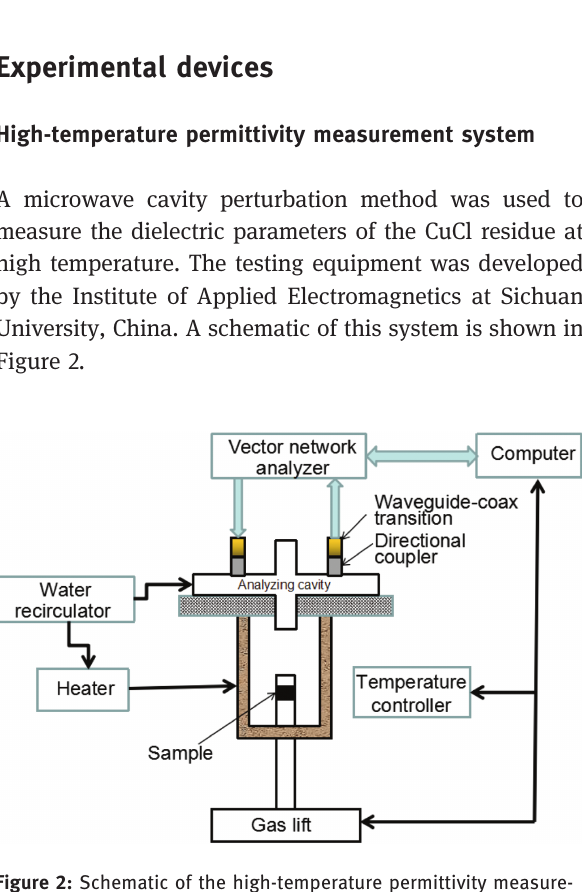
Figure 2: Schematic of the high-temperature permittivity measure- ment